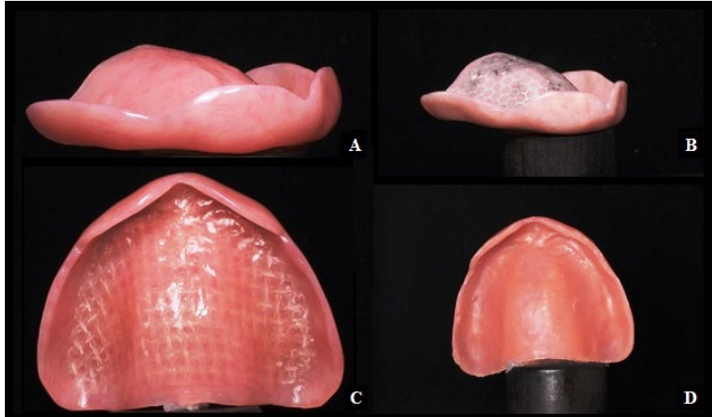
Table 2. Test specimen distribution and groups of materials.